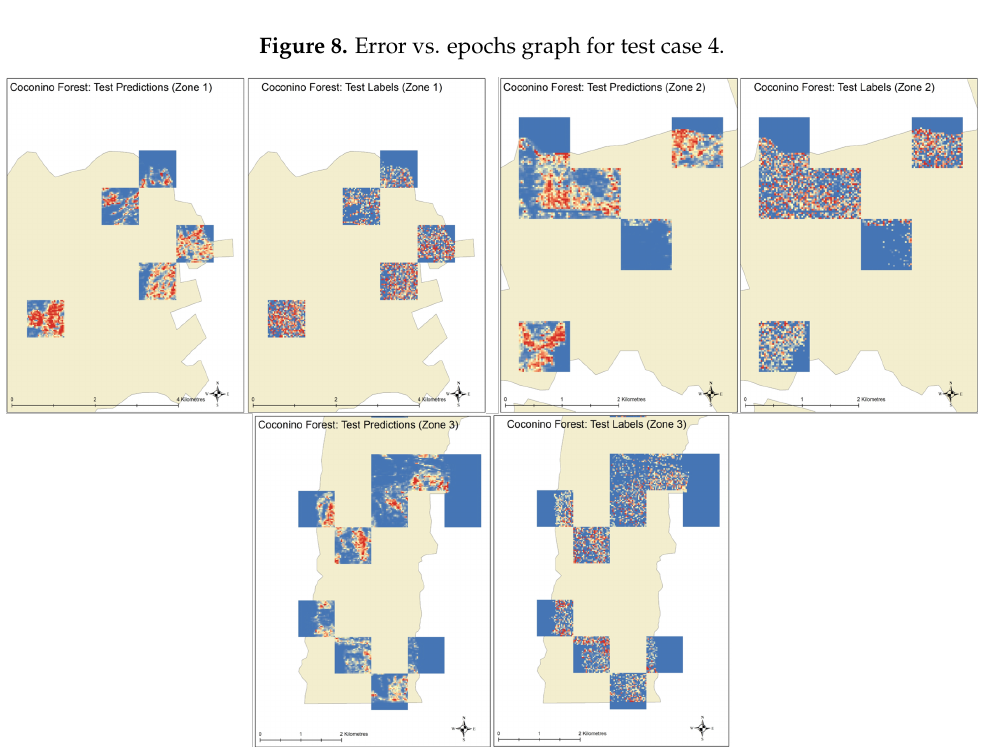
Figure 9. Visual comparison of predicted and actual canopy heights in different zones of area under